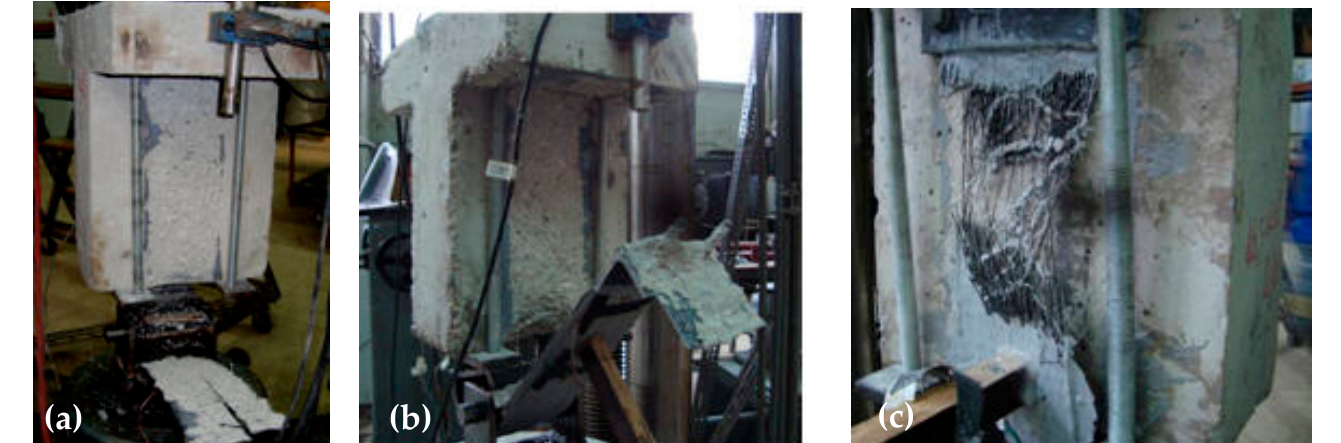
Figure 12. ( a ) Debonding mode of failure. ( b ) Failure of the anchoring scheme accompanied with debonding. ( c ) Tensile failure of the FRP strip.